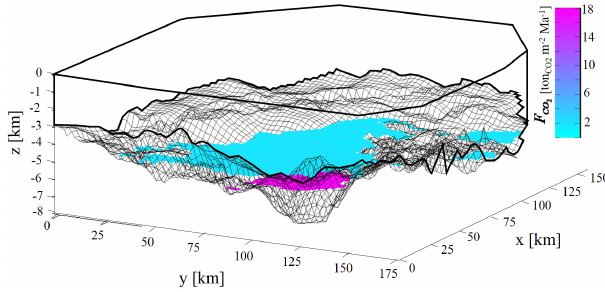
Figure 9. Three-dimensional illustration of activation surface yielded by pp 99 ( CO 2 ) for CCR1 and CCR2 and the correspond- ing CO 2 generation rate for each point of the activation surfaces (kgCO 2 m − 2 Ma − 1